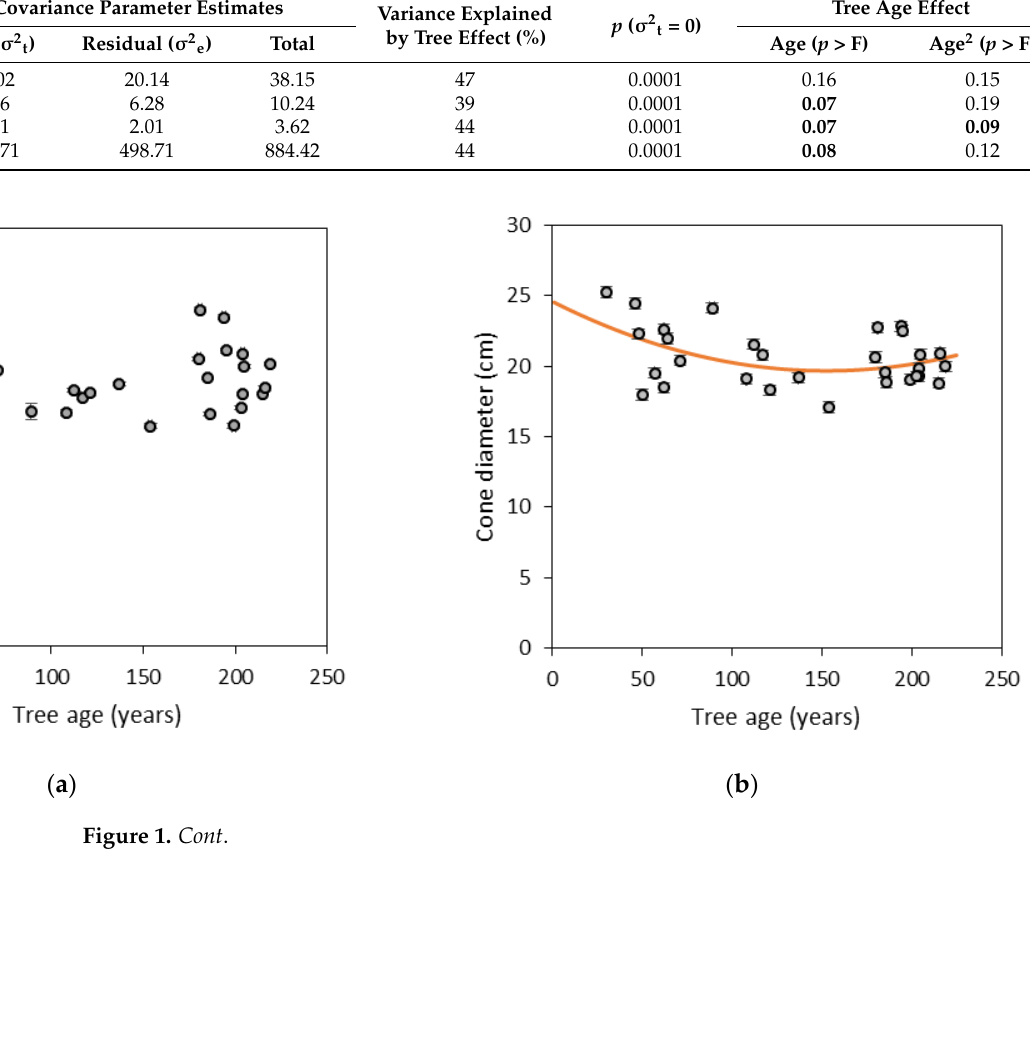
( d ) Figure 1. Mean values (±SE) (points) and fitted line (red line) for the morphological parameters of cones along the range of tree age analyzed: ( a ) length (in cm); ( b ) diameter (in cm); ( c ) weight (in g) and ( d ) volume (in cc). Fitted line is only shown for those traits showing a significant relationship with age. Results for the morphological traits of seeds showed significant differences between trees ( p = 0.0001, Table 3). The tree effect accounted for 22 to 45% of the total variability. These three seed traits were correlated (0.38 < r < 0.47, p < 0.0001). In addition, we recorded a negative correlation of seed weight (r = −0 .07, p = 0.0003) and length (r = −0 .12, p < 0.0001) with the age of the mother tree. Mean values for the studied traits were (SD, range): length = 4.8 mm (0.4, 4.2 to 5.8), diameter = 2.6 mm (0.2, 2.1 to 3.0) and weight = 9.2 mg (1.8, 6.6 to 14.2). The age of the mother tree had a significant effect on seed weight (Table 3, Figure 2). As in the previous case, for this trait, we also observed a significant decrease with age, up to a tree age over 150 – 175 years, when a slight increase in the values was detected. Table 3. Between-Tree Variability and Effect of Tree Age on Morphological Parameters of Seeds. When the effect of age is significant ( p < 0.1), the value is shown in bold.